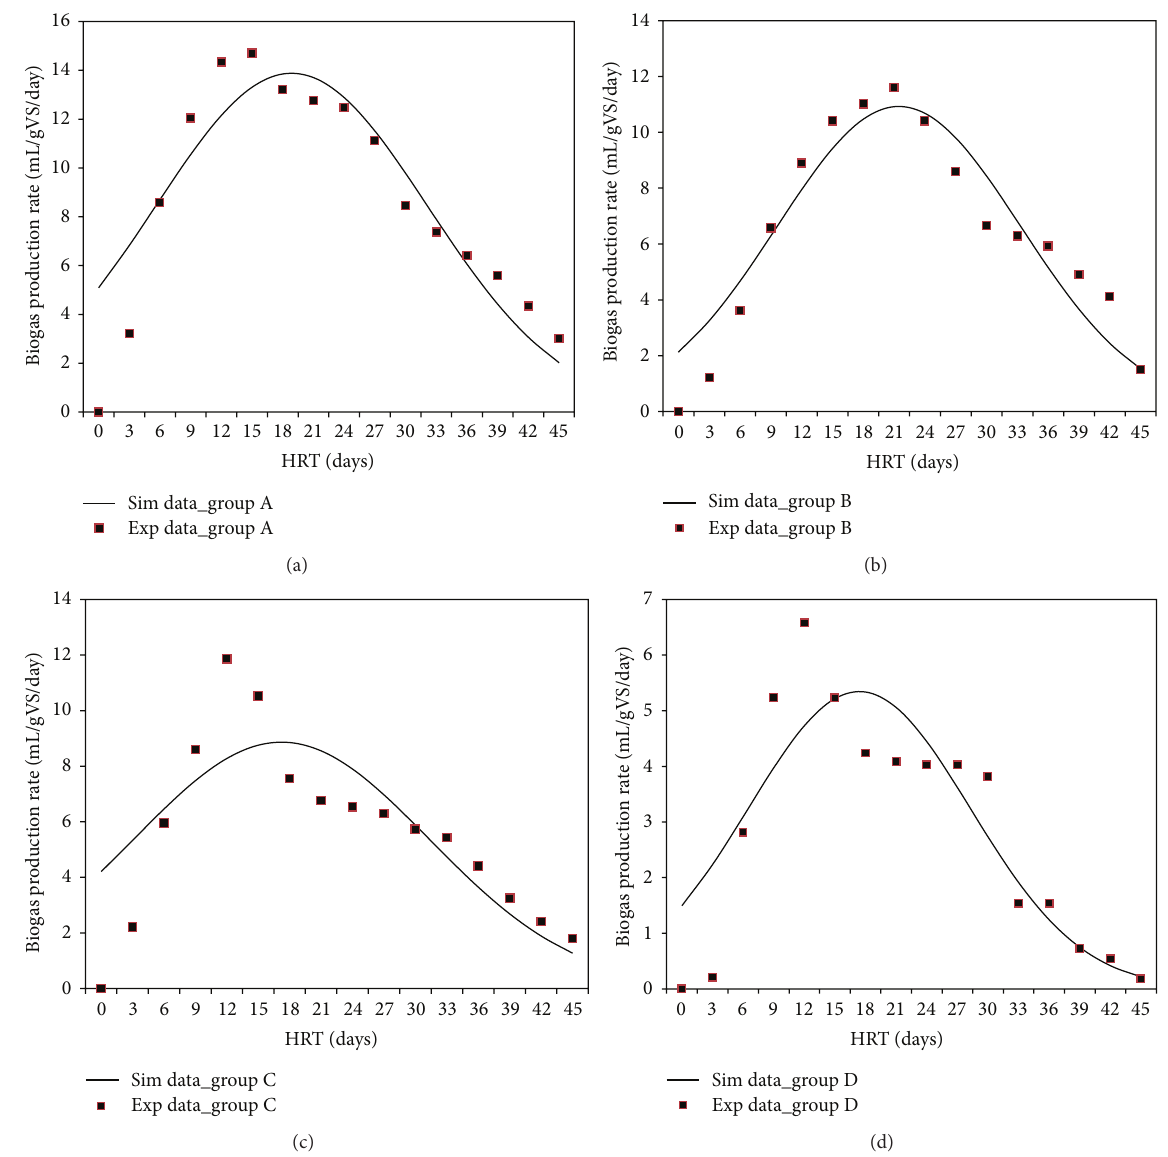
Figure 8: (a) Gaussian plot of cumulative biogas production for thermally treated biomass at 135 ∘ C (group A). (b) Gaussian plot of cumulative biogas production for treated biomass at 85 ∘ C (group B). (c) Gaussian plot of cumulative biogas production for untreated biomass (group C). (d) Gaussian plot of cumulative biogas production for the inoculum (group D).